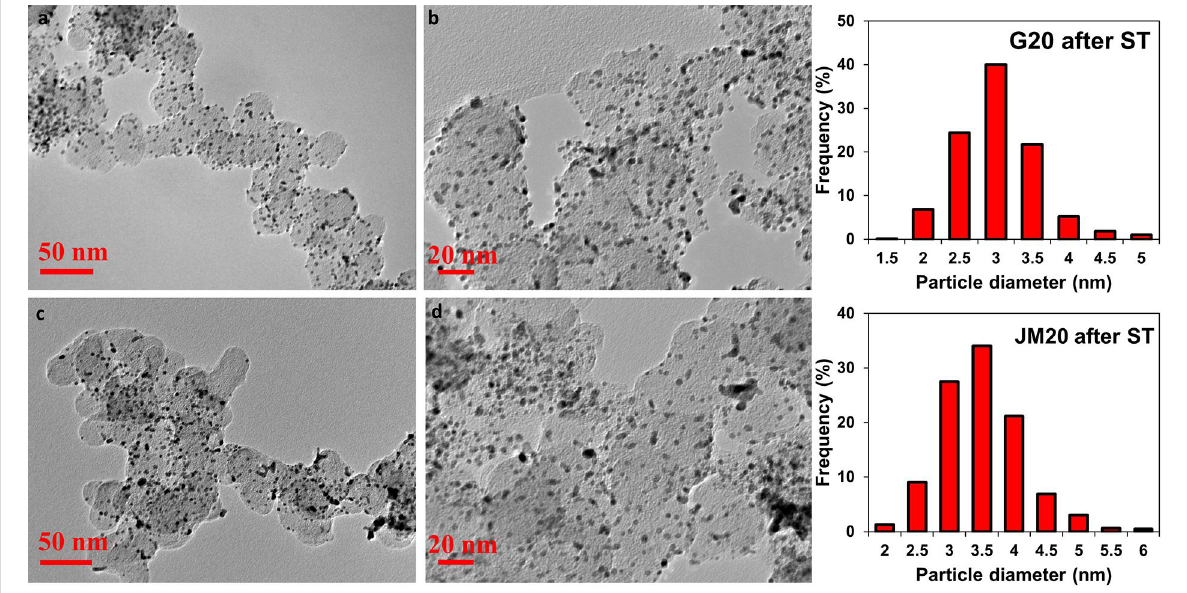
Figure 8: Micrographs of Pt/C samples of catalysts G20 (a,b) and JM20 (c,d) after stress test and histograms of nanoparticle size distribution of the corresponding materials.